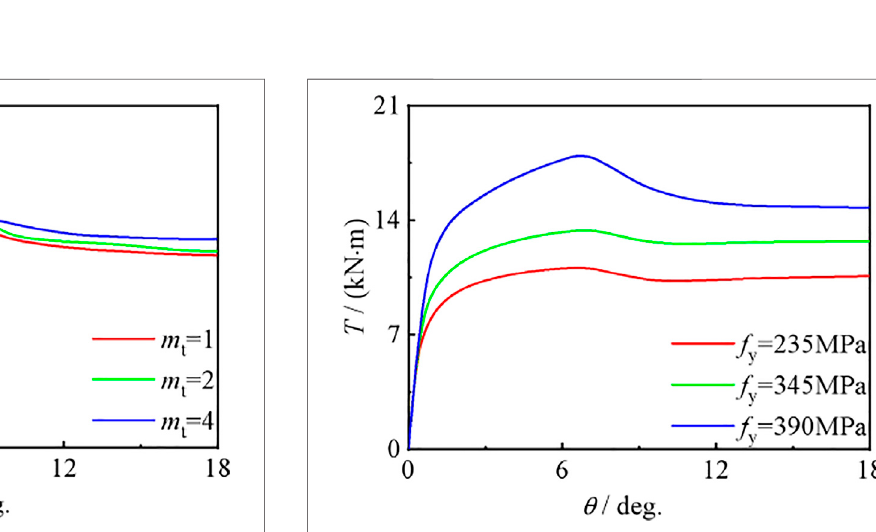
FIGURE 24 | f y effect on the T – θ curve of the compression torsion member.